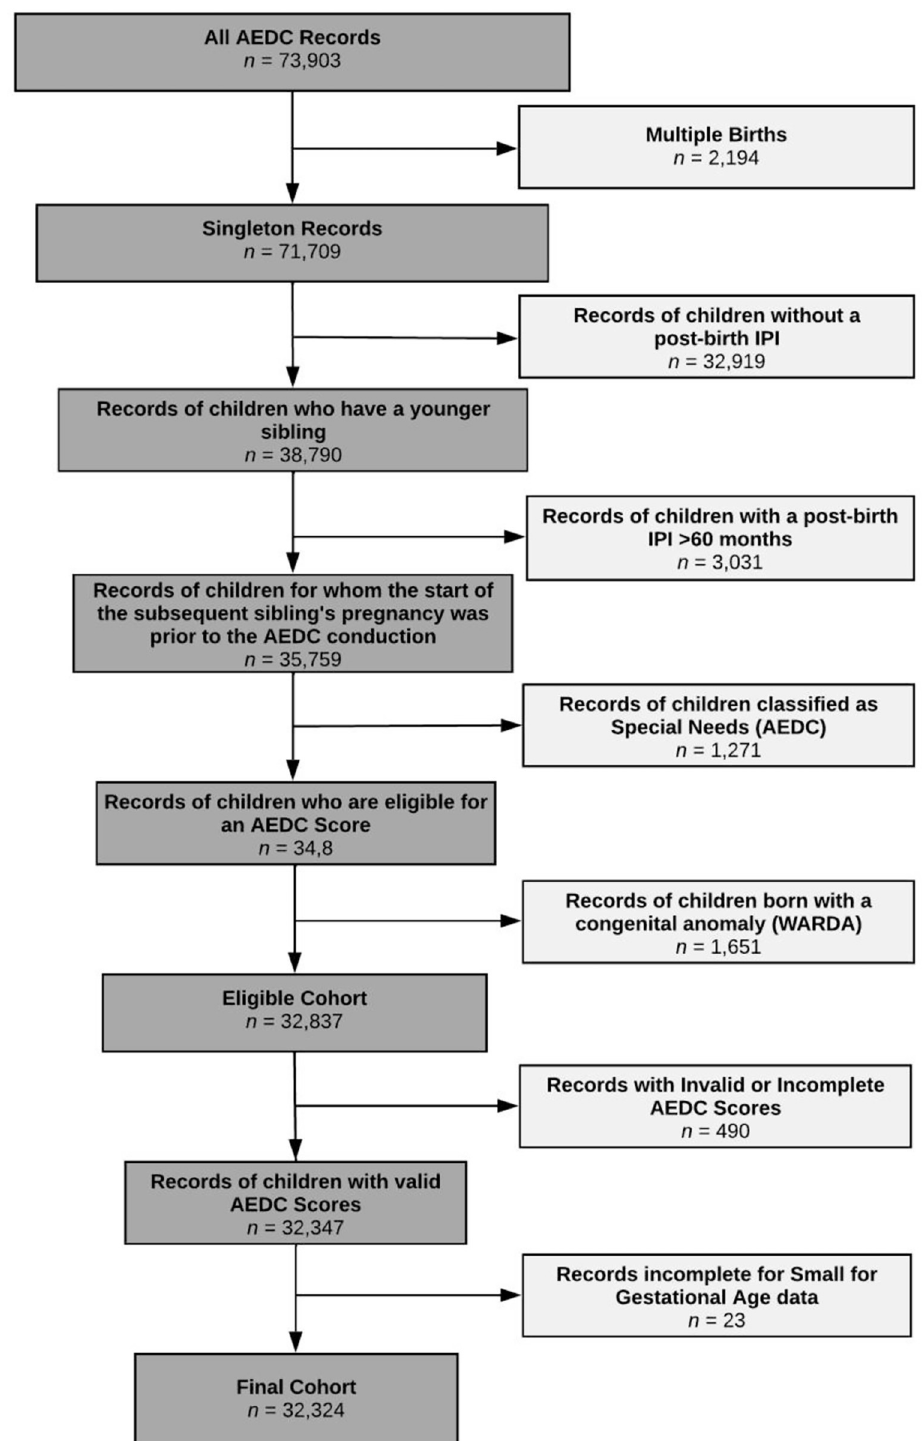
Fig 1. Eligible cohort and numbers included for analyses. AEDC = Australian Early Development Census. WARDA = Western Australian Register of Developmental Anomalies. IPI = Interpregnancy Interval.